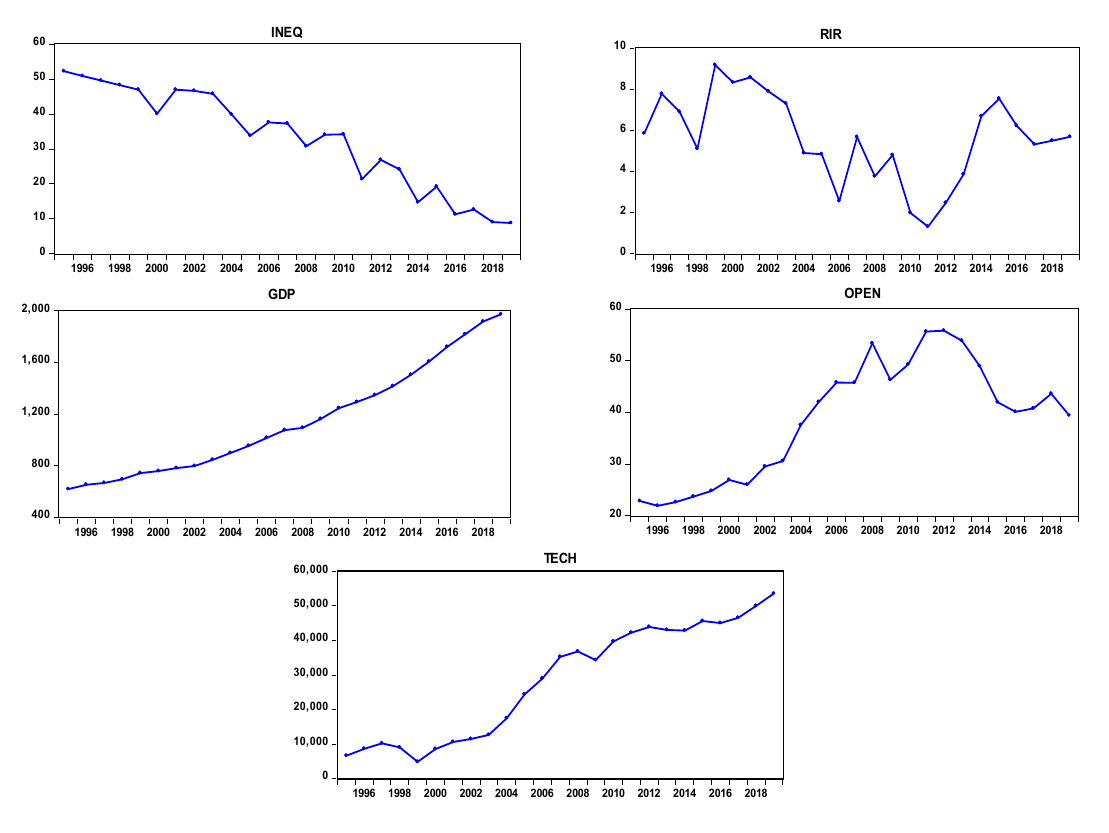
Figure 1. Trend plot of study